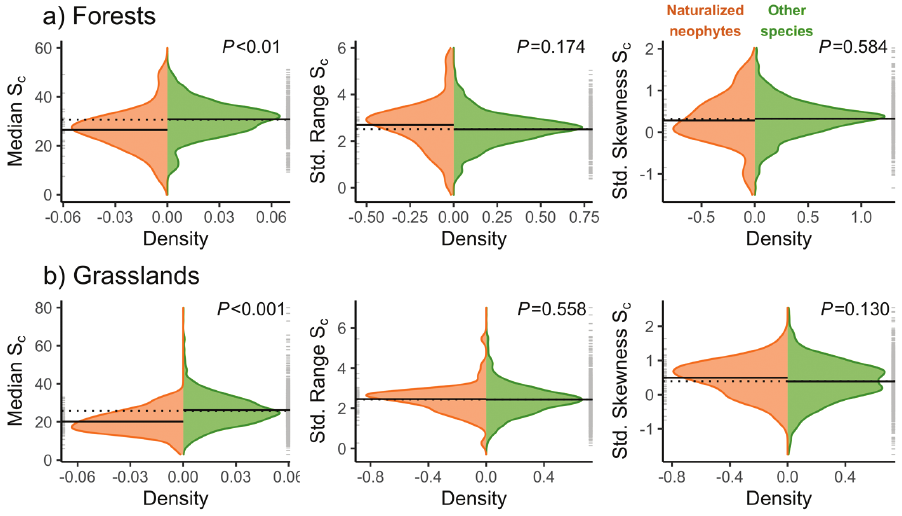
Figure 2. Density curves comparing the median (1 st column), range (2 nd column) and skewness (3 rd col- umn) of plot-size adjusted species richness ( S and ( b ) grasslands. The dotted black line indicates the mean of S species in the vegetation formation. The solid black line indicates the mean of the S rameter of each species group. The tick marks on the left and right margins show the S parameter of individual species in each group. Density values of naturalised neophytes were multiplied by -1 to facilitate visual comparisons. The range and skewness of S the Methods section. P -values correspond to Mann-Whitney U